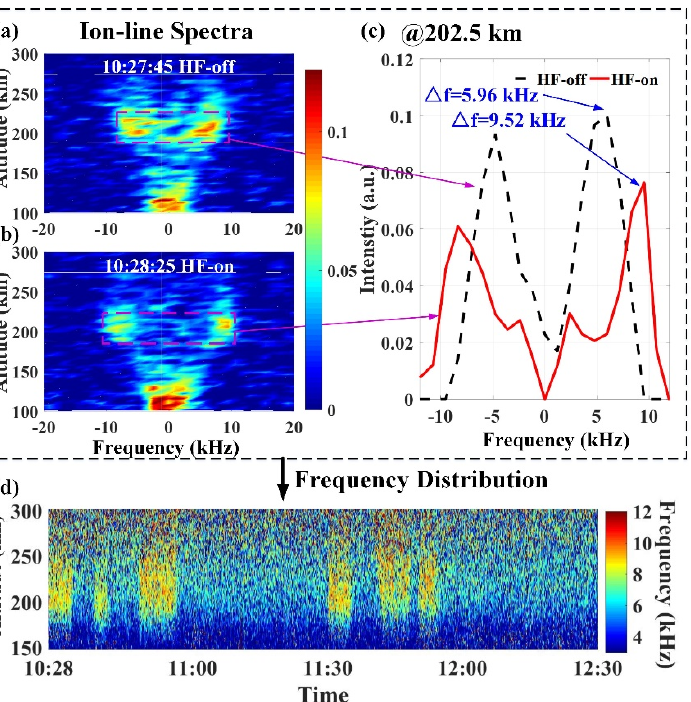
Figure 8. ( a , b ) show the ion-line spectra with the HF-pump off and on, respectively. The x-axis represents the Doppler frequency and the y-axis represents altitude, with the pseudocolors corresponding to the echo power amplitude. ( c ) depicts the ion lines with the HF-pump off and on at 202.50 km in the maximum electron heating region. ( d ) presents the frequency distribution of the ion-line maximum intensity.